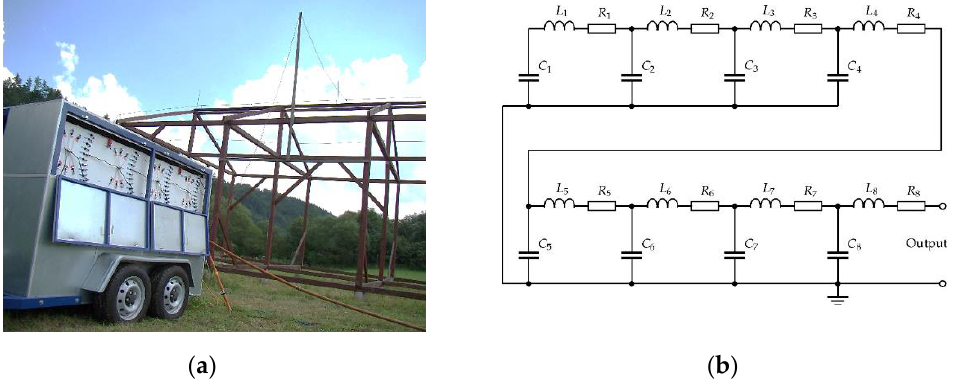
Figure 3. The long duration current pulse generator: ( a ) General view of the generator on the test site; ( b ) simplified schematic of the generator main circuit: C 1 , L 1 , R 1 —first segment; C 2 , L 2 , R 2 —second segment; C 8 , L 8 , R 8 —eighth (last)